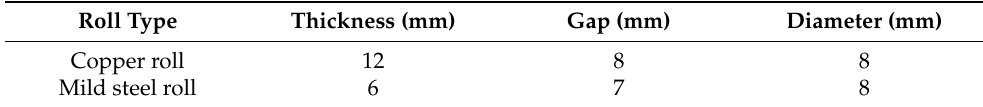
Figure 2. Schematic showing cooling water channel. Dimensions are given in Table 1. Table 1. Dimensions of cooling water channel shown in Figure